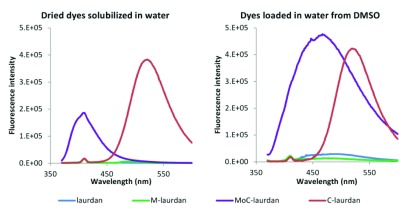
Fluorescence emission in water.Left panel: For all four dyes, the volumes of chloroform stock solutions corresponding to 3 nanomoles were dried in test tubes under nitrogen, followed by further evaporation with a vacuum pump for 2 hours. Water (3 ml) was added to each sample (final theoretical concentration: 1 µM), which were vortexed for 30 seconds at room temperature and emission spectra were then measured with a FLSP920 (Edinburgh Instruments, Scotland) fluorimeter with excitation set to 360 nm.Right panel: Dyes were dissolved in DMSO to obtain stock solutions of 1 mM. 3 microliters from those DMSO stock solutions were injected in 3 ml of water (final concentration of 1 µM). Emission spectra were then measured with a FLSP920 (Edinburgh Instruments, Scotland) fluorimeter.The very small peak at 410 nm corresponds to the Raman of water, as a consequence of the excitation set to 360 nm.